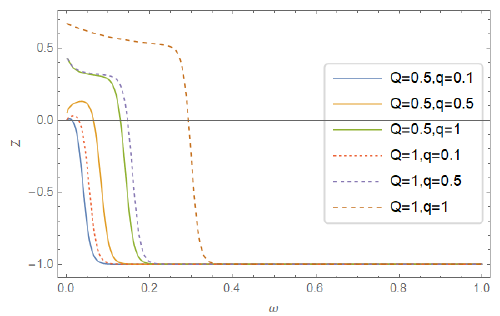
Figure 4. The amplification factor Z